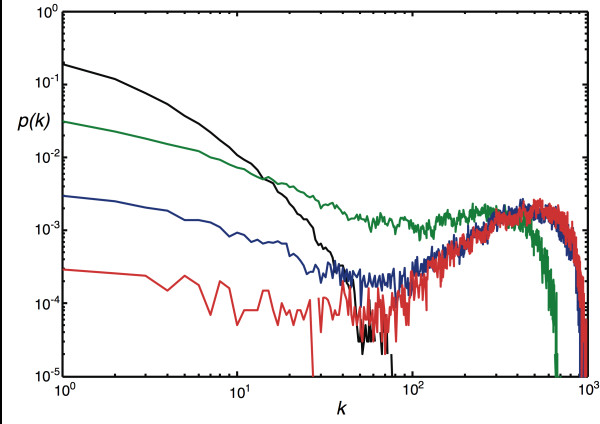
Edge distributions for networks grown under different regimes. PN = 1.0 (black line, exponential distribution) PN = 0.1 (green), PN = 0.01 (blue), and PN = 0.001 (red). All other parameters are set to PE = p = q = 0.75, PD = 0.5, r = 1.0. Networks are unmodular and undirected, grown to size n = 10, 000, averaged over 100 replicates.